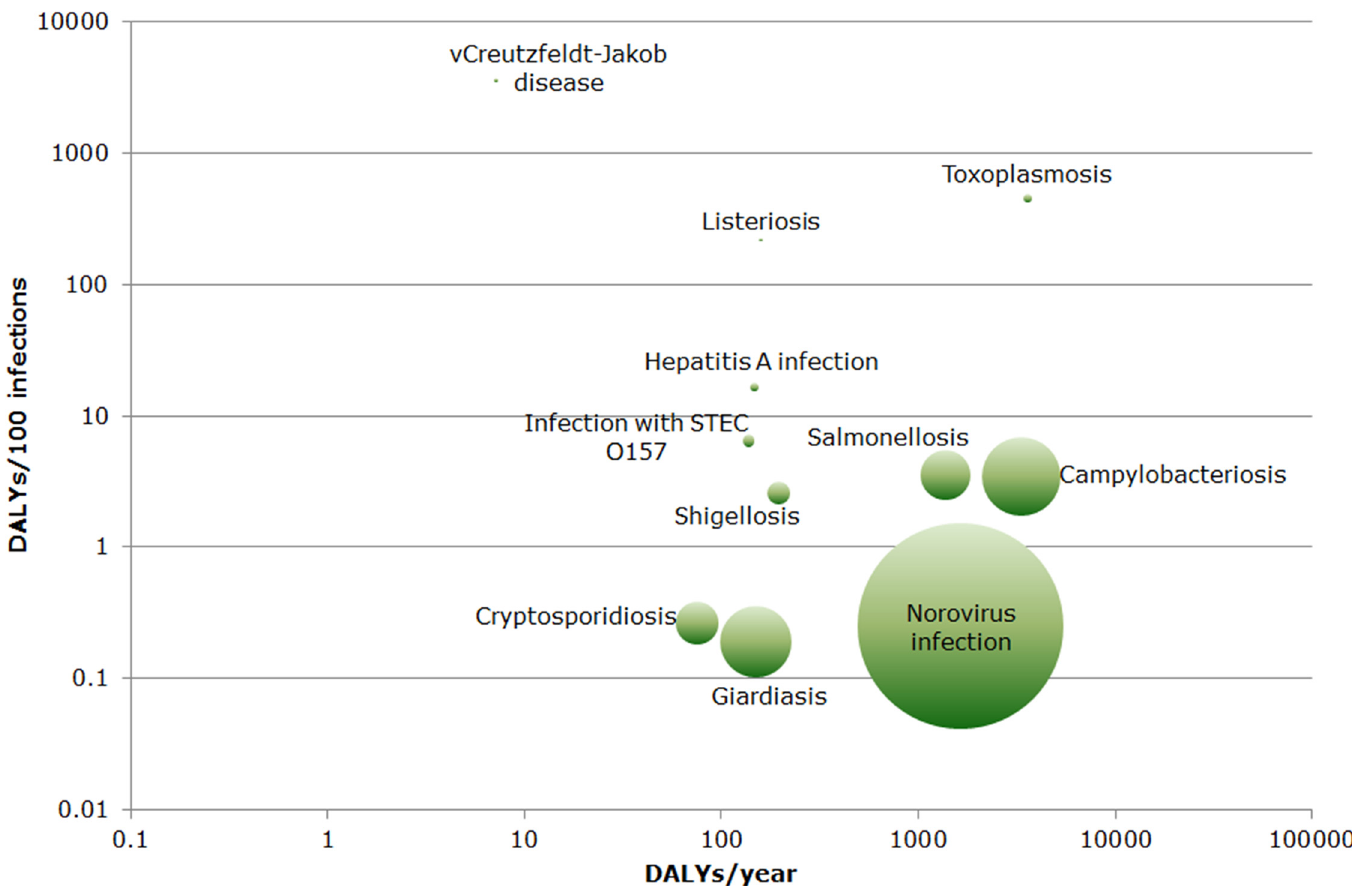
Fig 6. Ranking of food-related diseases by disease burden at population/individual level in the Netherlands in 2007 – 2011. The area of each bubble is proportional to the average number of estimated annual cases (200 cases were added to each bubble for visibility reasons). Both axes are on a logarithmic scale. (DALY = Disability-Adjusted Life Years, population level = number of DALYs/year, individual level = number of DALYs/100 infections).